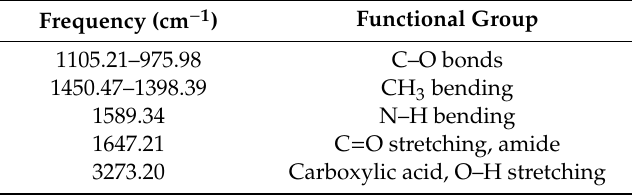
Table 2. FT-IR band assignment in the spectrum of crude bioflocculant from Bacillus nitratireducens